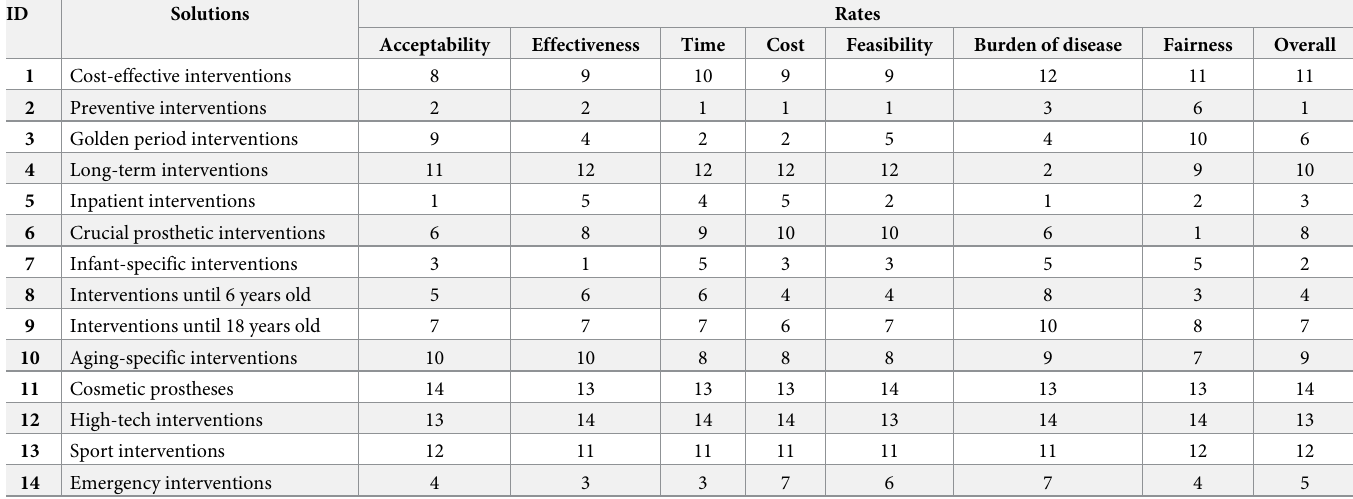
Table 1. Potential solutions and their weighted preferences to consider the P&O services in the Iranian HBP.